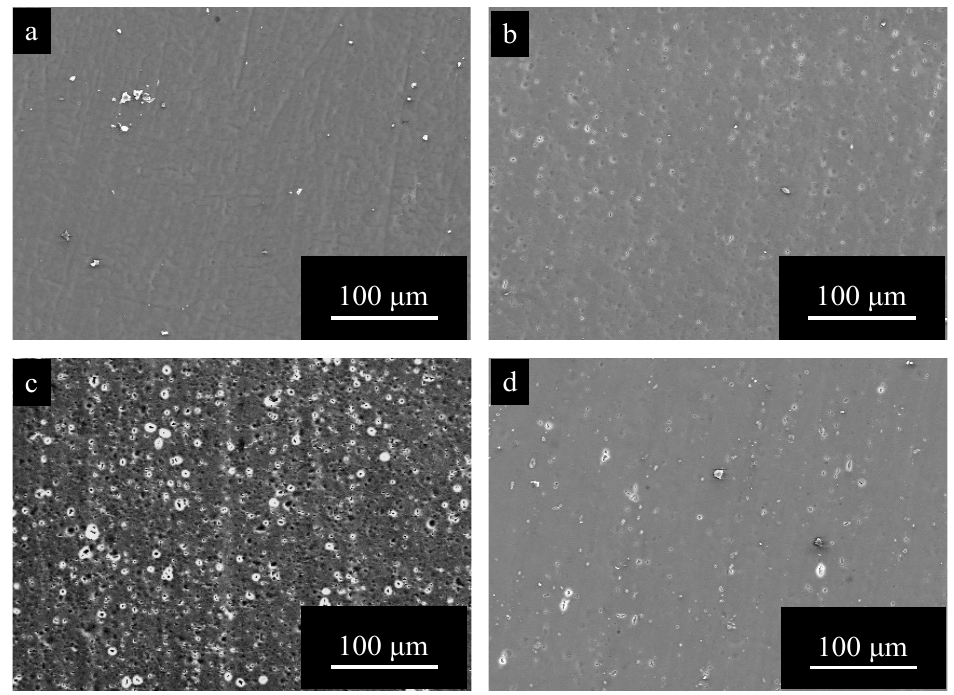
Figure 14. SEM image of the surface of ( a ) pure Al, ( b ) 1050-Al alloy, ( c ) 3003-Al-alloy, and ( d ) 5052-Al alloy, obtained by heating at T h = 373 K for 1200 s in air after anodizing for t a = 3600 s.